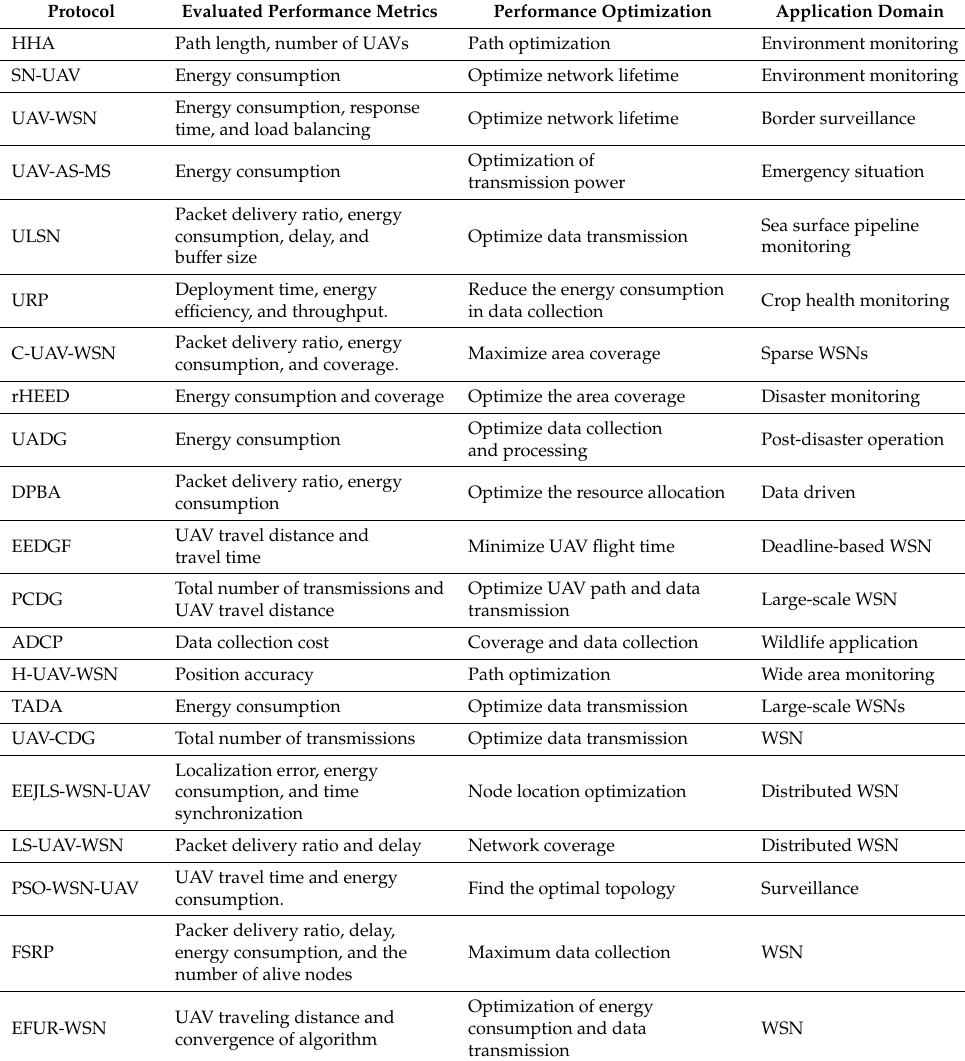
Table 5. Performance metrics and performance optimization of existing routing protocols for